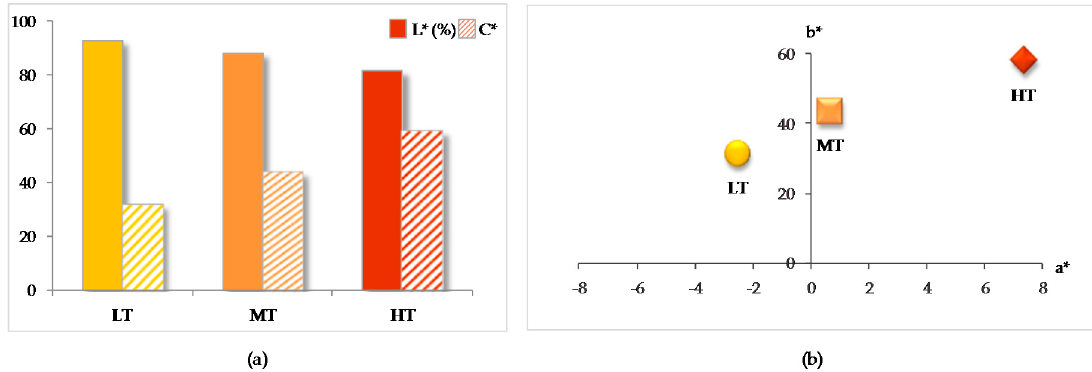
Figure 6. Mean values ( n = 56) of chromatic characteristics of the wine spirits aged in barrels with different toasting levels: ( a ) lightness (L*) and saturation (C*); ( b ) chromaticity coordinates (a*, b*);